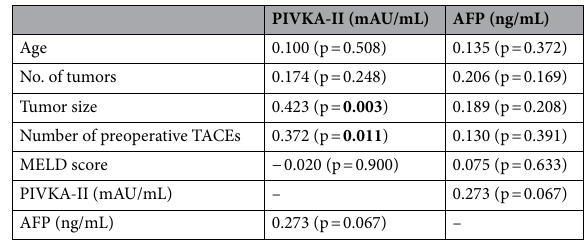
Table 2. Correlation between serum biomarkers levels and clinicopathological characteristics using Spearman test. Significant values are in